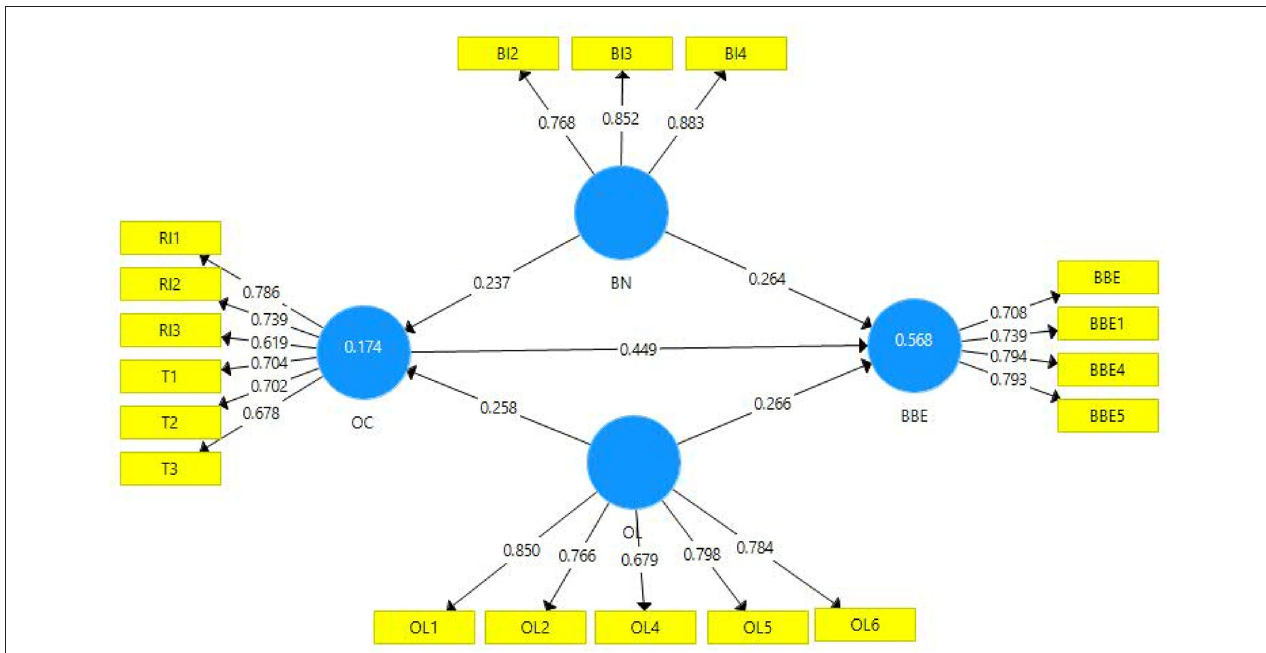
FIGURE 2 | Path diagram.